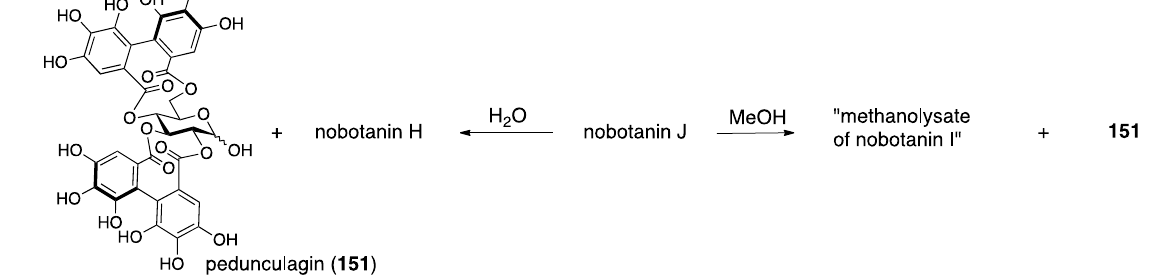
Figure 57. The transformation used in the structural determination for the first structure of nobotanin J ( 170 ).